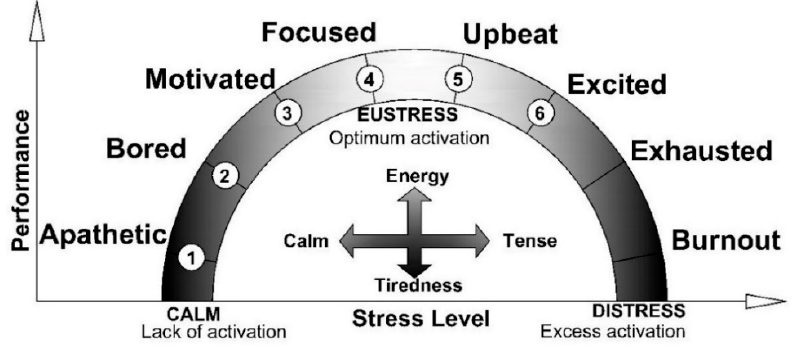
Figure 8. Performance curve.